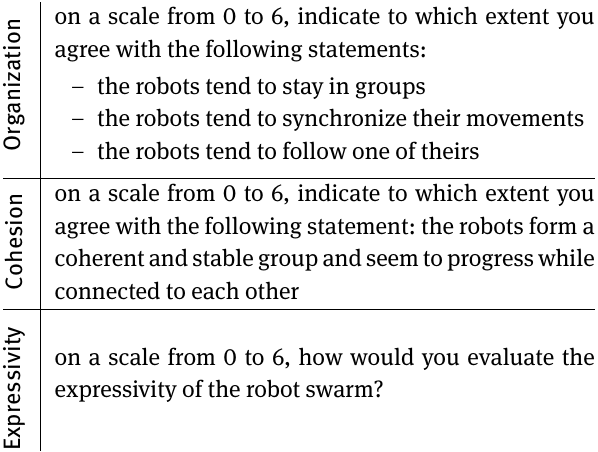
Table 3: Three scales to assess the values of organization, cohesion and expressivity attributed to the